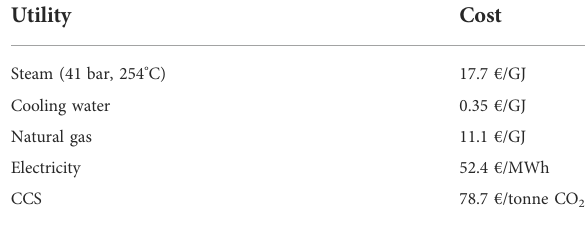
TABLE 5 Assumed utility costs for the process in 2021 Euros (Naims, 2016; PWC, 2016; Turton and Shaeiwitz, 2017). Utility Steam (41 bar, 254 ° C)